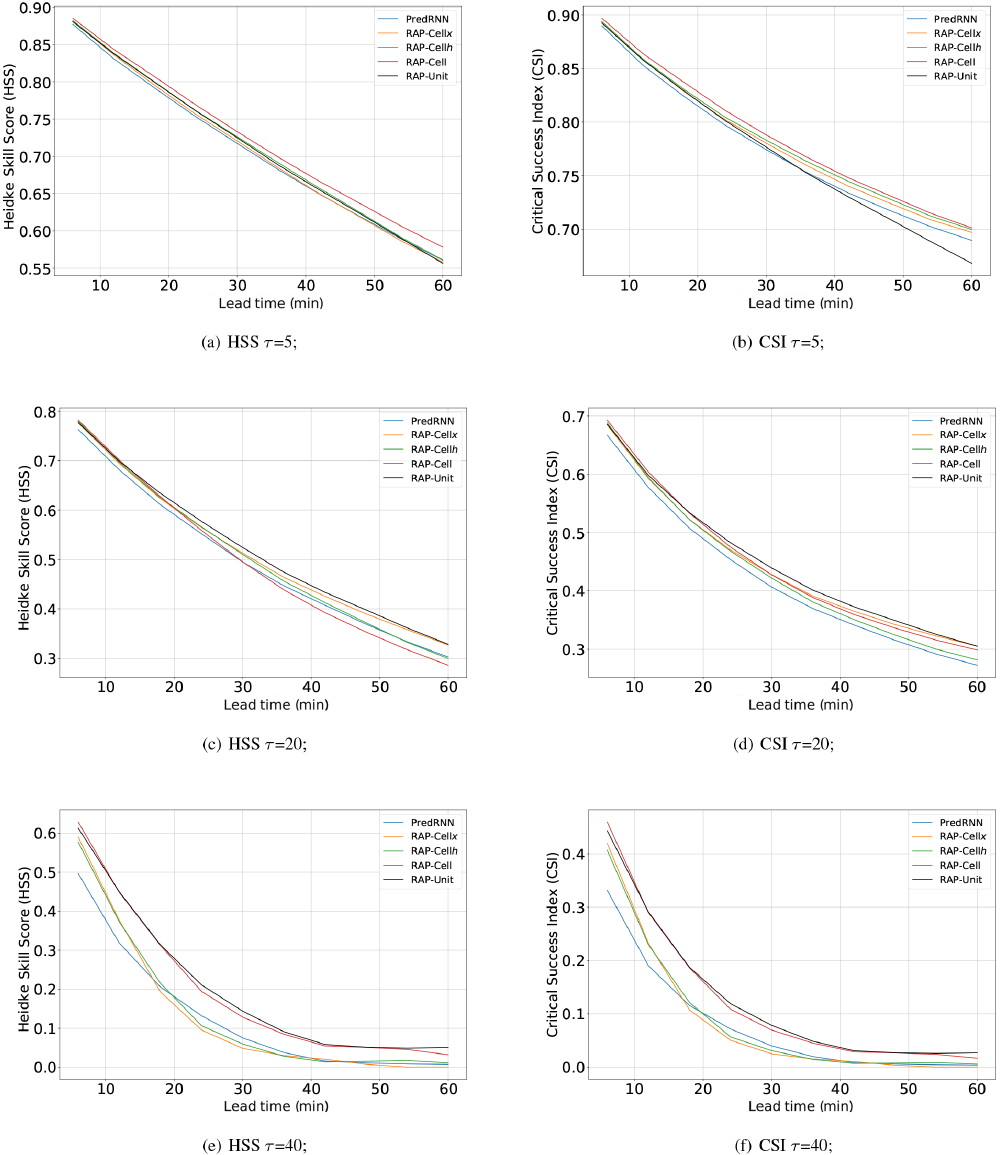
Figure 8. The performance changes against different nowcast lead times in terms of HSS and CSI scores in the ablation study (best viewed in